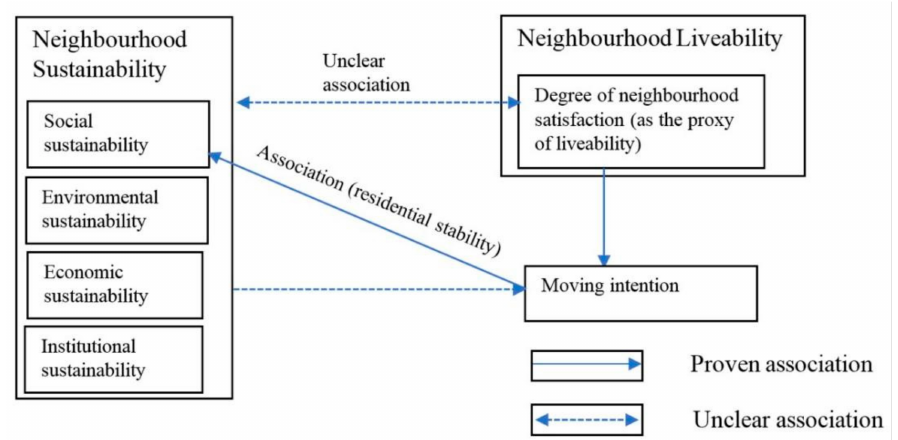
Figure 1. Conceptional framework of theoretical association with neighbourhood sustainability, satisfaction, and moving